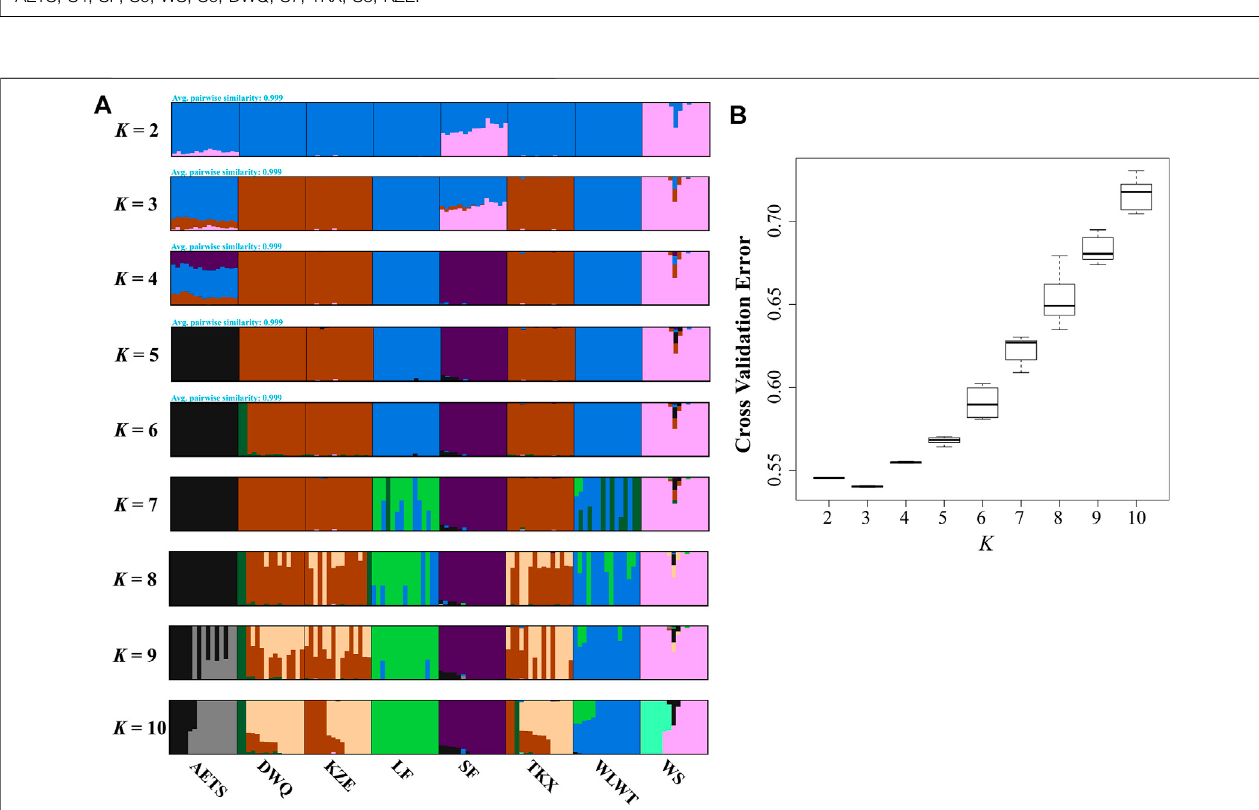
FIGURE3| PopulationgeneticstructurebasedonSNPdataof120 T.tenuis individuals. (A) Clusteringinformationfordifferentpopulationswhen K =2 – 10; (B) The CV error varies among K values.